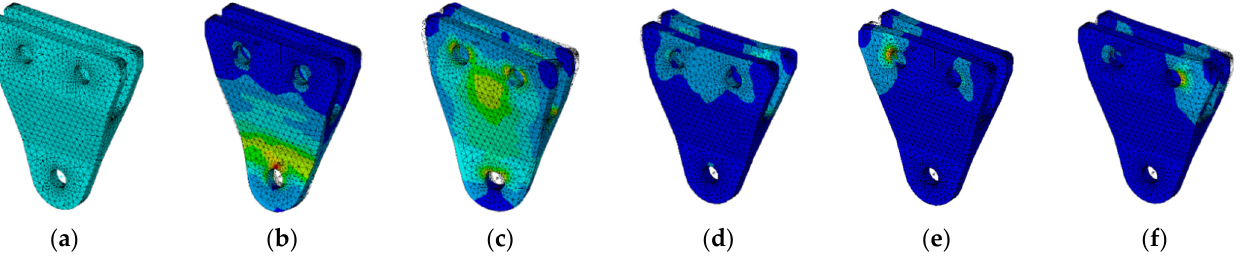
Figure 13. Finite element model of flexible auxiliary lever arm and modal diagrams of the first five modes: ( a ) finite element model; ( b – f ) first to fifth modes.